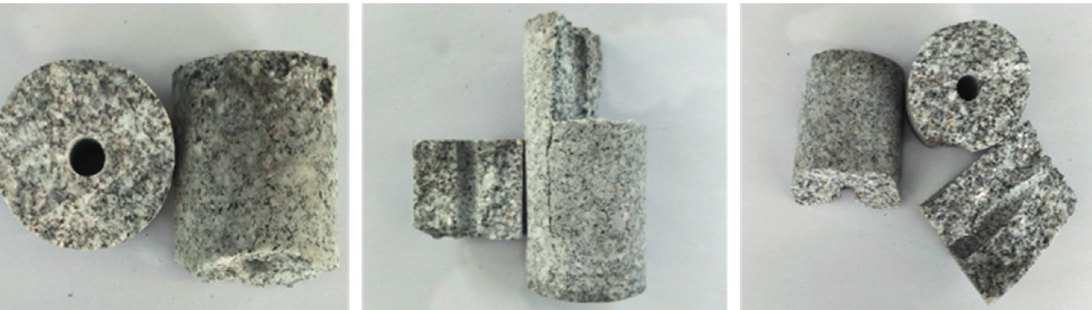
Figure 11: Fracture failure morphology of granite specimens with a vertical hole under different impact pressures of equal-amplitude impact.